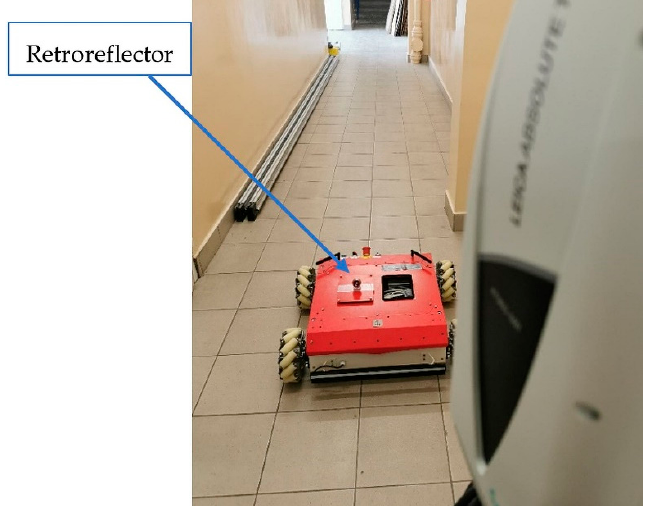
Figure 9. Positioning a 4-wheel mobile robot with mecanum wheels using a Leica laser tracker.